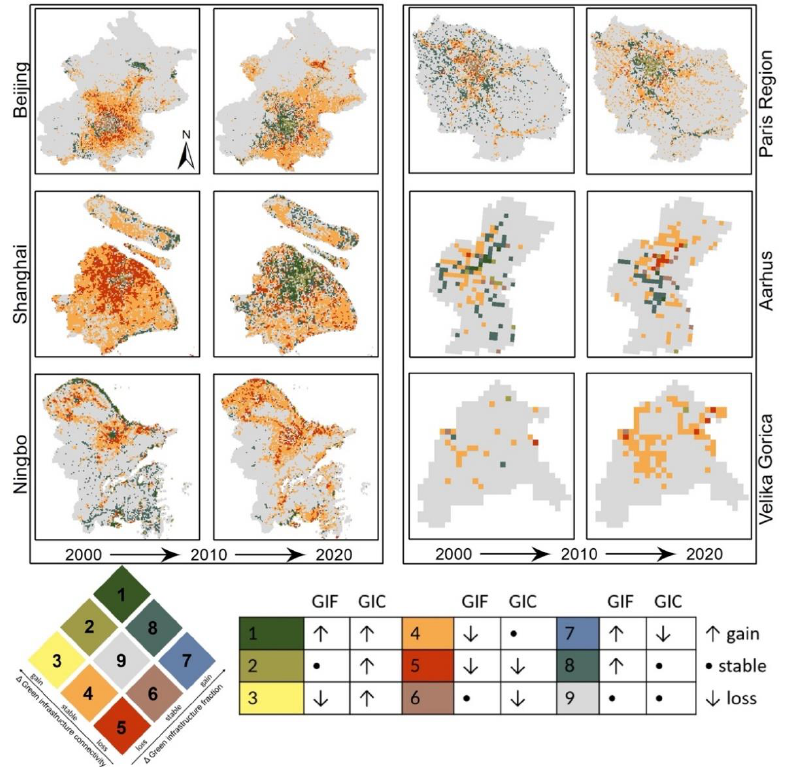
Figure 5. The spatial distribution of the combined changes in GIF and GIC for the two time periods (2000 to 2010 and 2010 to 2020), where indicators are considered to have increased or decreased significantly when the absolute value of the change is greater than 5%.